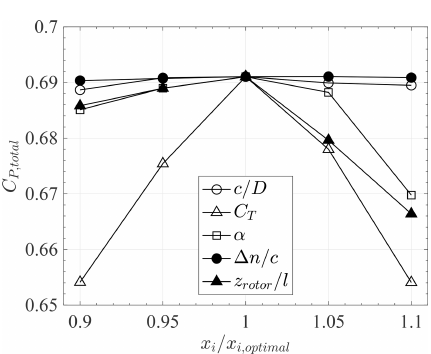
Figure 8. The sensitivity of the total power coefficient of the opti- mal design to different design